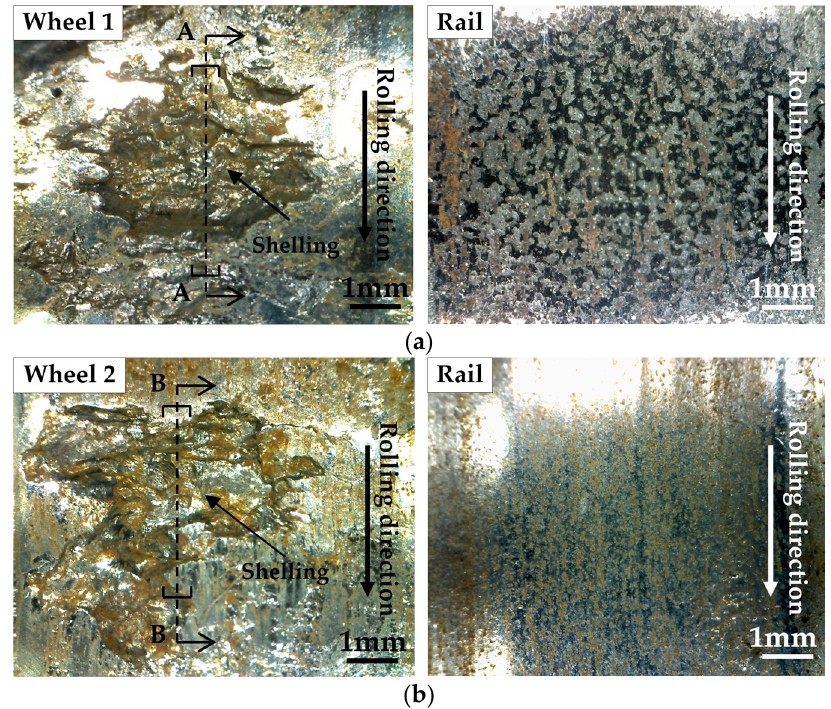
Figure 6. Surface damage on wheel rollers (second layer) and rail rollers after tests: ( a ) wheel 1 (standard wheel) test; ( b ) wheel 2 (improved wheel) test.